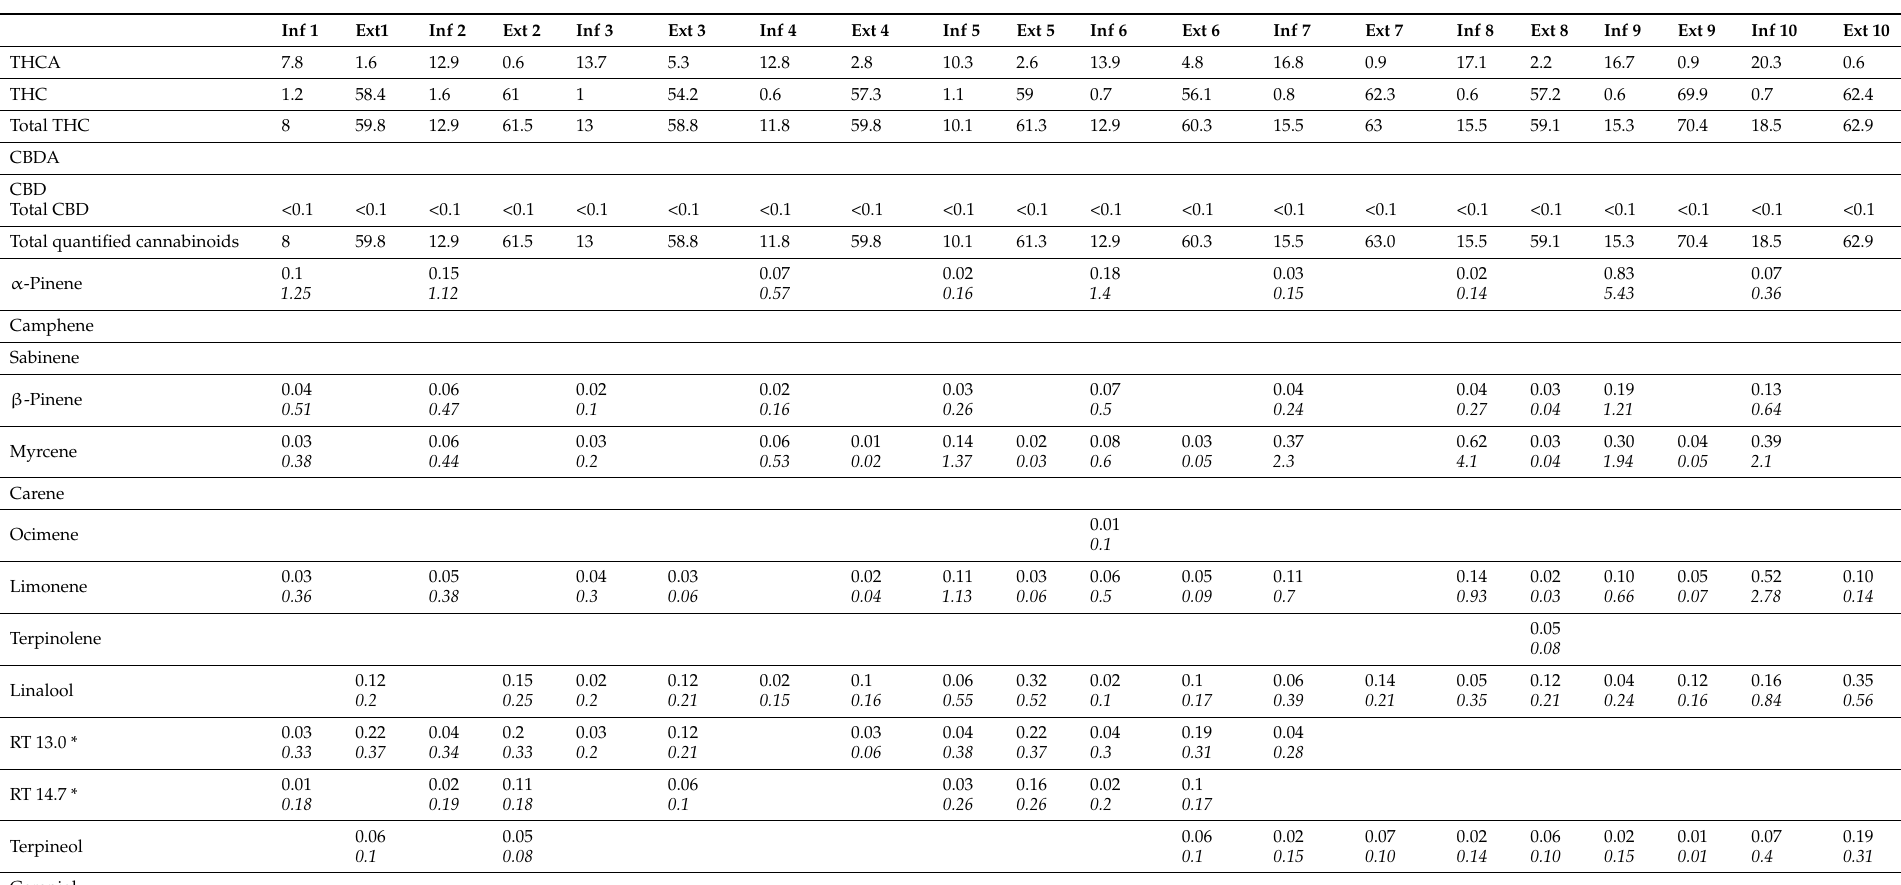
Table 4. Cannabinoid and terpene compositions in various inflorescences and in decarboxylated extracts produced from them. Data is presented as